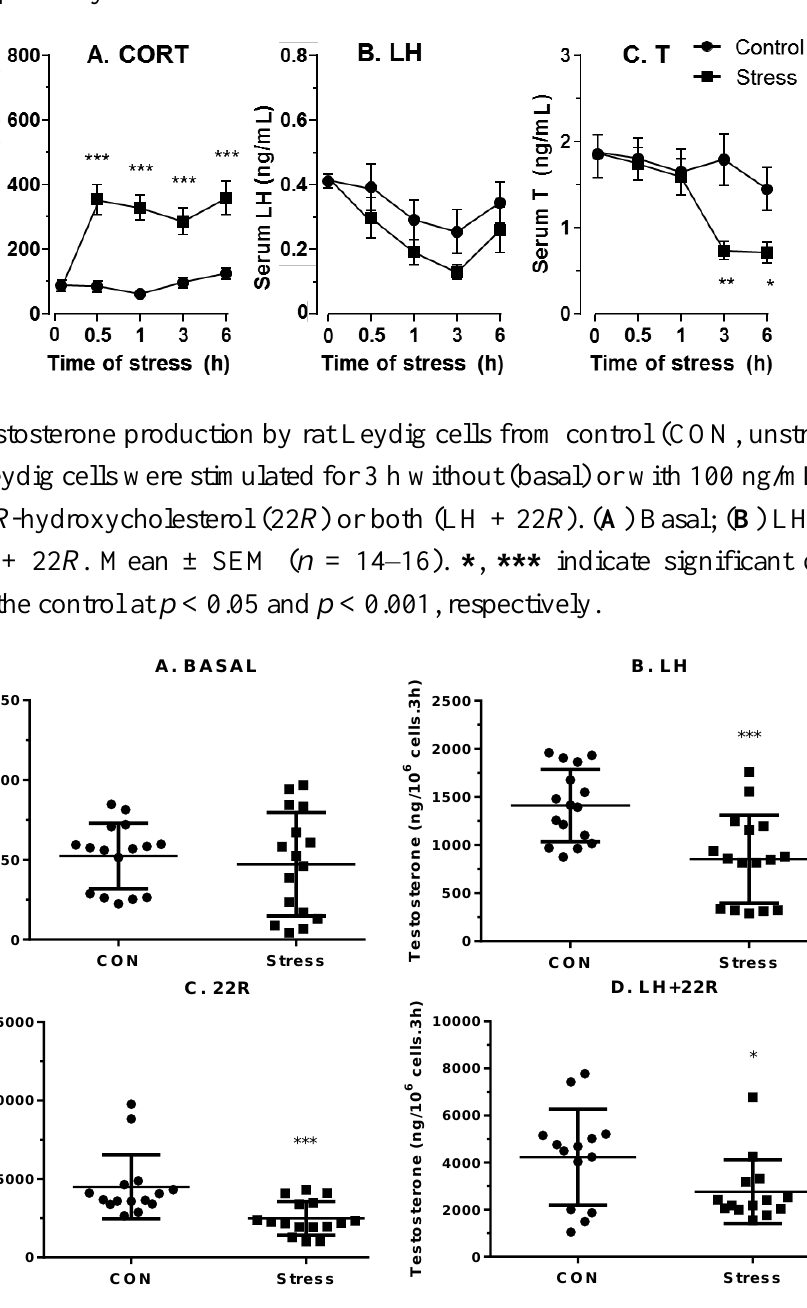
mediated testosterone production of Leydig cells (Figure 2), confirming that the reduced plasma levels of testosterone were caused by the defects of Leydig cell steroidogenesis. Figure 1. Plasma corticosterone (CORT), luteinizing hormone (LH) and testosterone (T) levels during the course of stress. ( A ) Plasma CORT; ( B ) Plasma LH; and ( C ) Plasma T levels. Mean ± SEM ( n =12–25, each time point). n = 12 for 0 h group, in which animals of the control and stress group were calculated together. * , ** and *** indicate significant difference compared to control (unstressed) at each time point at p < 0.05, p < 0.01 and p < 0.001, respectively.